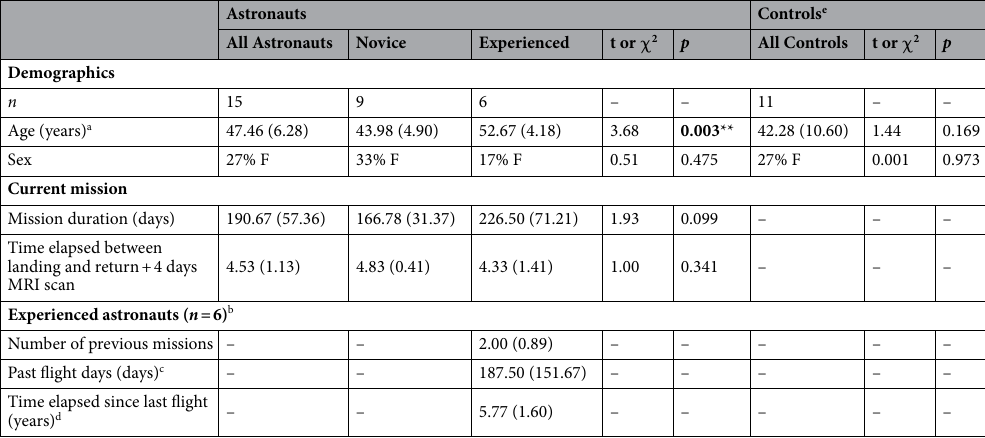
Table 1. Astronaut and control group demographics and flight experience. ** p < 0.01. For each metric, we report the mean (standard deviation) for the whole astronaut cohort, the novice and experienced subgroups, and the whole control group. We also report the results of two-sample t-tests to characterize differences in demographic variables between the novice and experienced astronaut groups, and between the whole astronaut cohort and the whole control group. For sex, we report the percentage of females included in each group and the result of a Pearson’s Chi-square test for differences in the sex distribution within each group. a Age represents age, in years, at the date of launch for the astronauts and age at the first MRI scan for the controls. b Here, we report further details regarding previous spaceflight experience for n = 6 of 15 astronauts who completed at least one flight before the current ISS mission. c Past flight days indicates the total number of previous days spent in flight, not including the current mission. d Time elapsed since the last flight is the time from the landing day of the most recent flight to the launch of the current mission. e Here we include only those control group participants with complete MRI datasets ( n = 11). See “Methods” for further details. Significant values are in